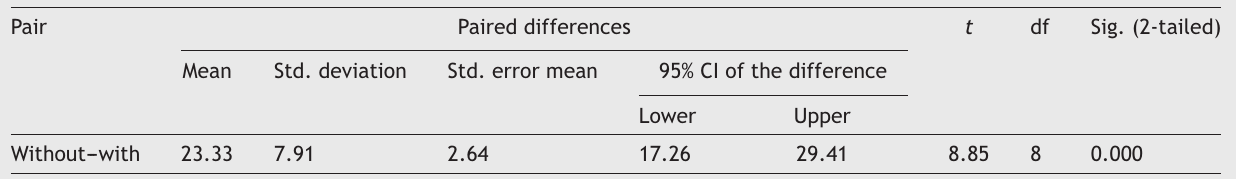
Verification of the significance of the results using paired t -test.